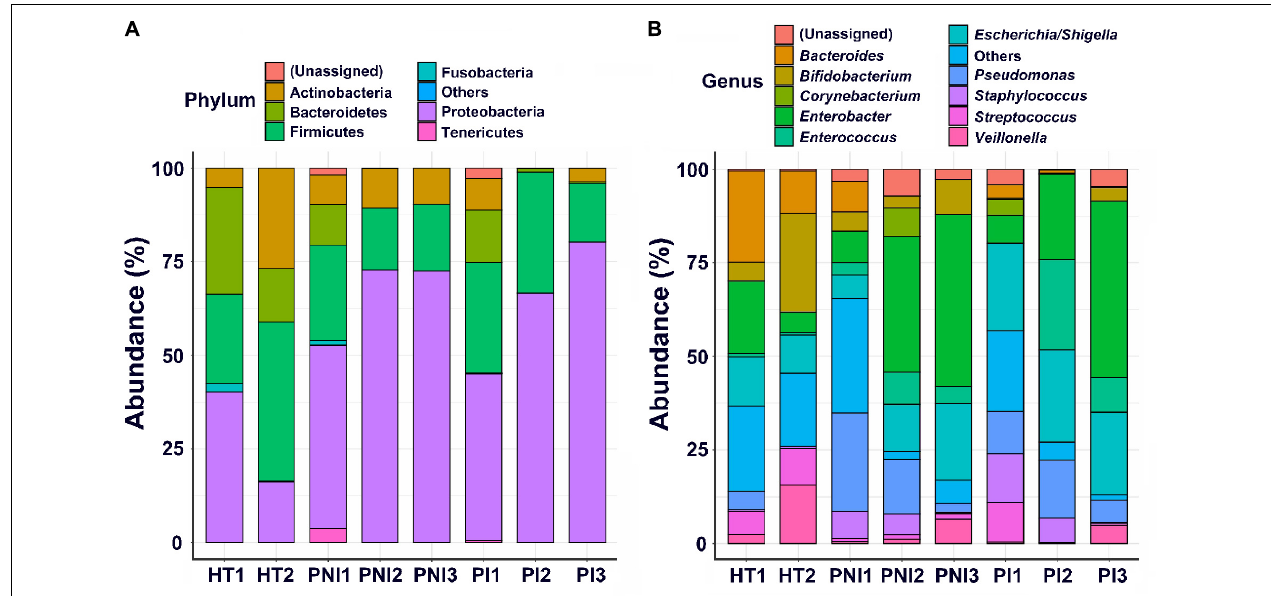
FIGURE 2 | Abundances of bacterial taxa in different groups of the infants. Mean relative abundances of bacterial taxa at phylum (A) and genus (B) levels in each group of the stool collections. HT, healthy term infants; PNI, preterm infants without invasive infections; PI, preterm infants with invasive infections.